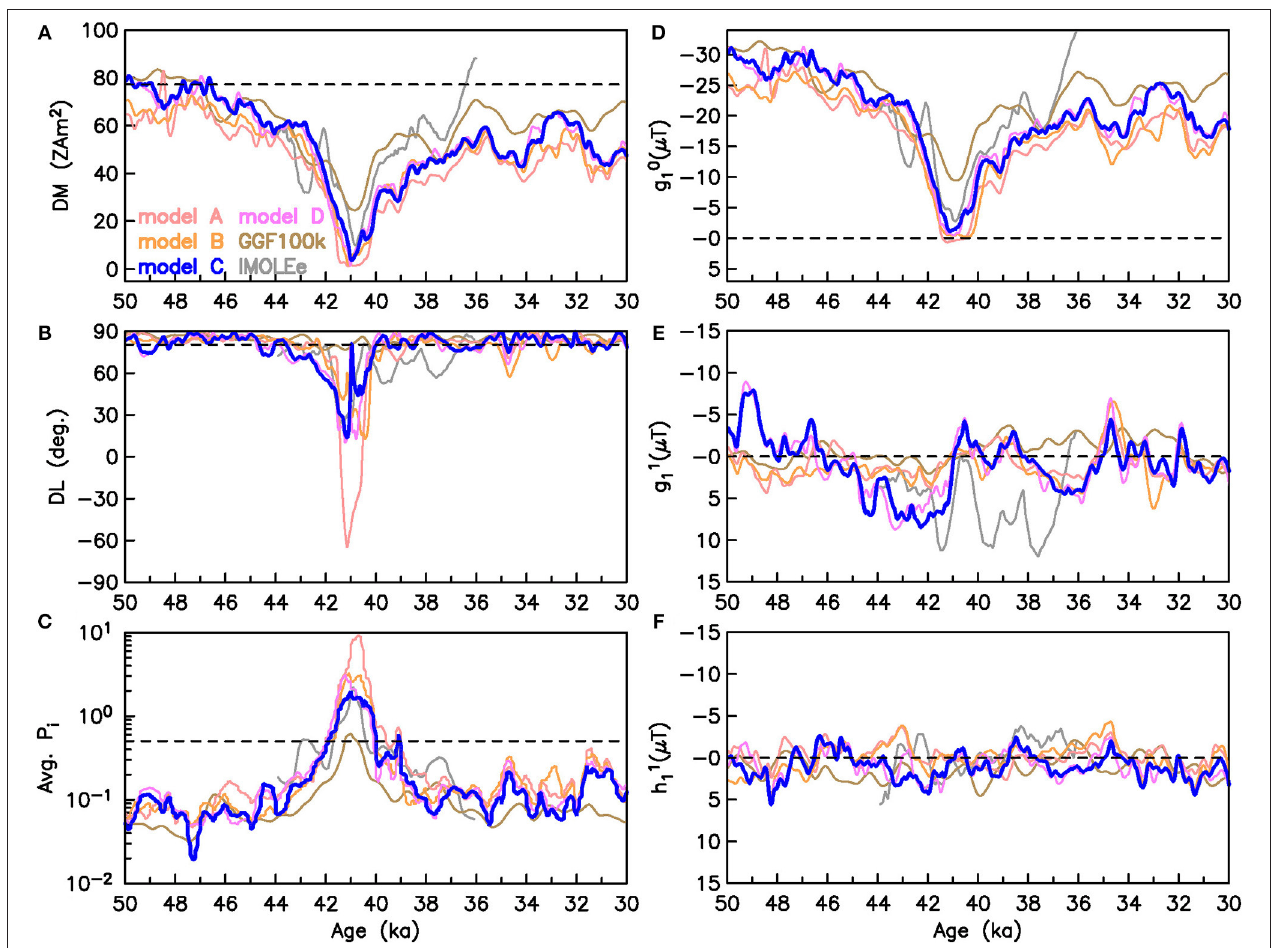
FIGURE 3 | Comparison of the six models in terms of (A) dipole moment (DM), (B) dipole latitude (DL), (C) PSV index P i , and the three SH dipole coefficients (D–F) at Earth’s surface. Dashed lines indicate present day values in (A) and (B) , 0.5 suggested as limit for excursional behavior (Panovska and Constable, 2017) in (C) and zero in (D) , (E) , (F) . Model C (LSMOD.2) is our preferred